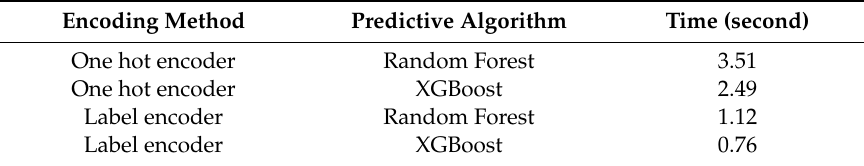
Table 2. The prediction speeds of the developed four models.